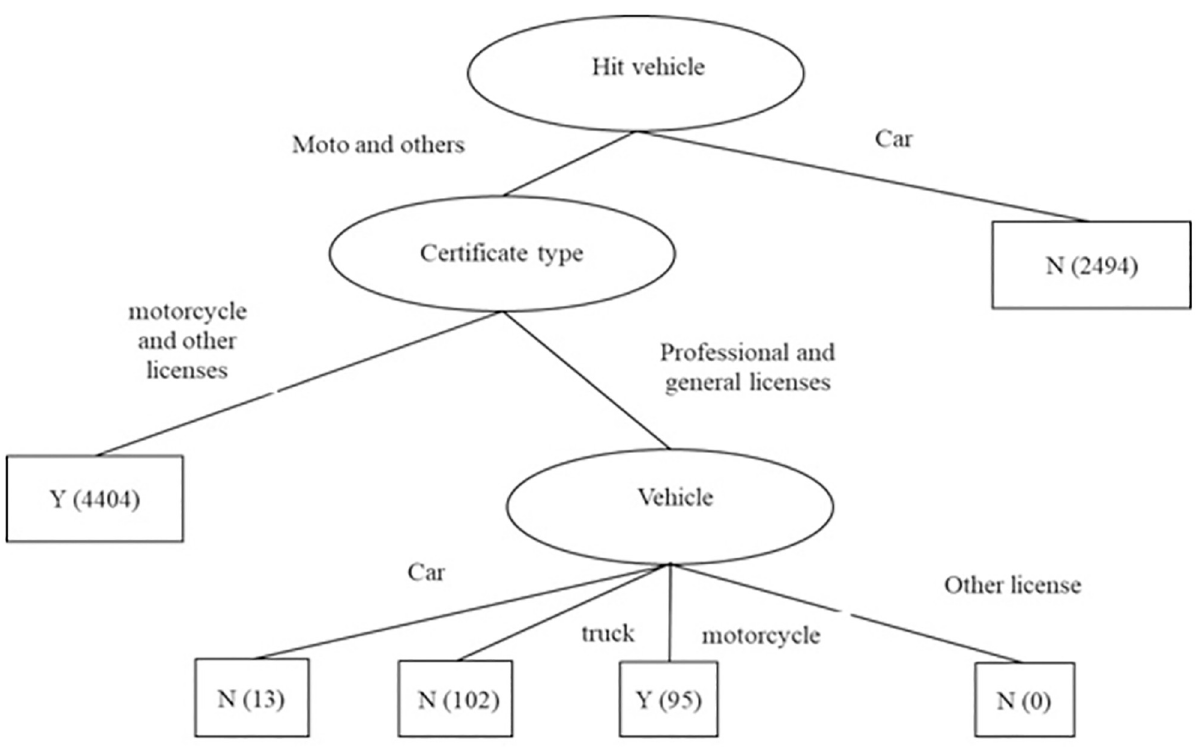
Fig 2. DT diagram of accident severity in the CR � 10 dataset. Note: Y denotes injury or death, N denotes uninjured.